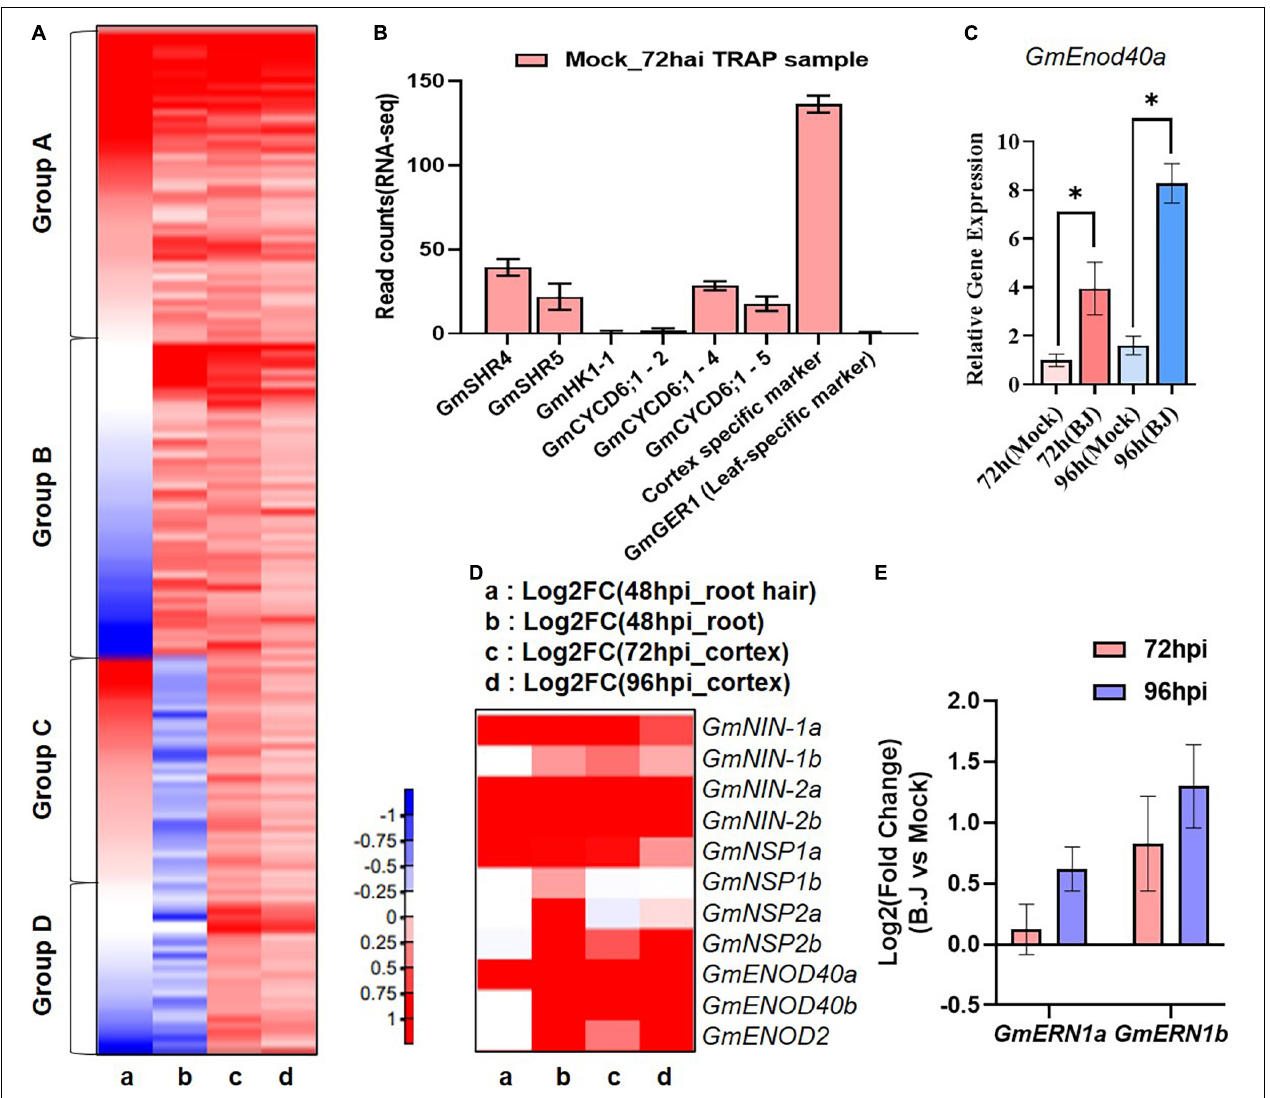
FIGURE 2 | Comparison of gene expression during early nodule development. (A) Heatmap of RNA-seq transcriptome analysis for 640 selected genes in (a) 48 hpi_root hair (Libault et al., 2010) (b) 48 hpi_root (Hayashi et al., 2012) (c) 72 hpi_TRAP-seq (d) 96 hpi_TRAP-seq. Heatmap were generated base on Log2 fold change of gene expression in response to B. japonicum inoculation ranging from decreased (blue) to increased (red) as show in the color gradient at the bottom right corner. (B) Expression of the vascular-specific genes in TRAP-seq data. (C) q-RT PCR of GmEnod40b in the corresponding whole transgenic hairy root samples with or without B. japonicum (Black asterisk indicate the t -test significance at p < 0.001). (D) Heatmap of well-characterized nodule-associated genes in RNA-seq data sets. Heatmap were generated in the same way as (A) . (E) The expression of well-characterized nodule development-associated genes in the TRAP-seq data